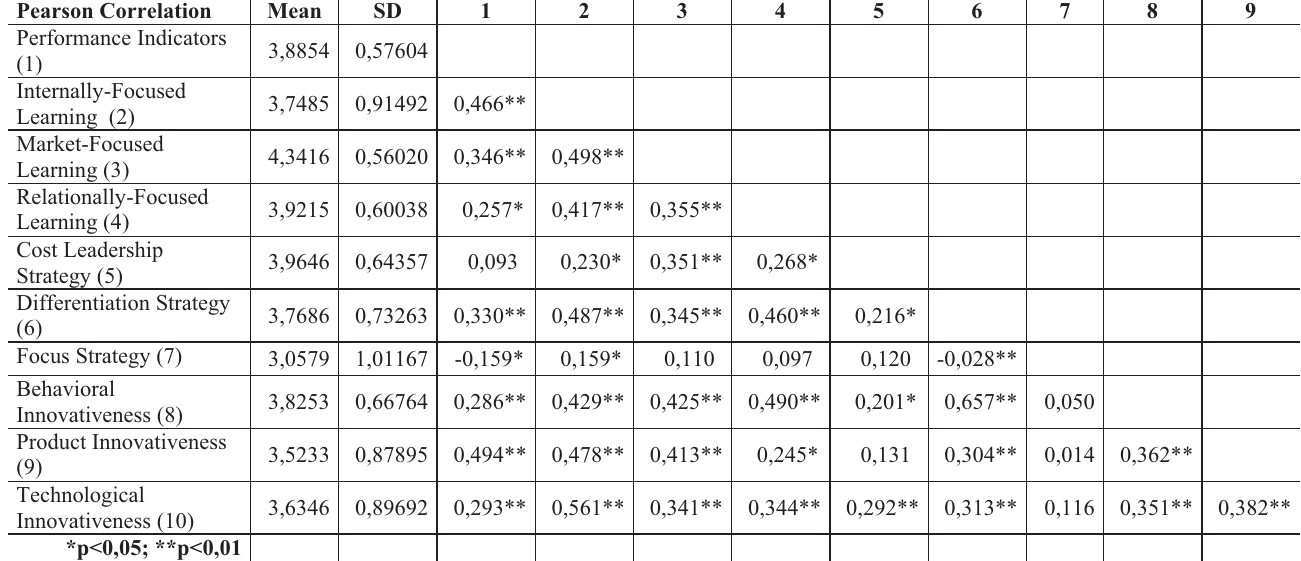
Table 2: Pearson correlation